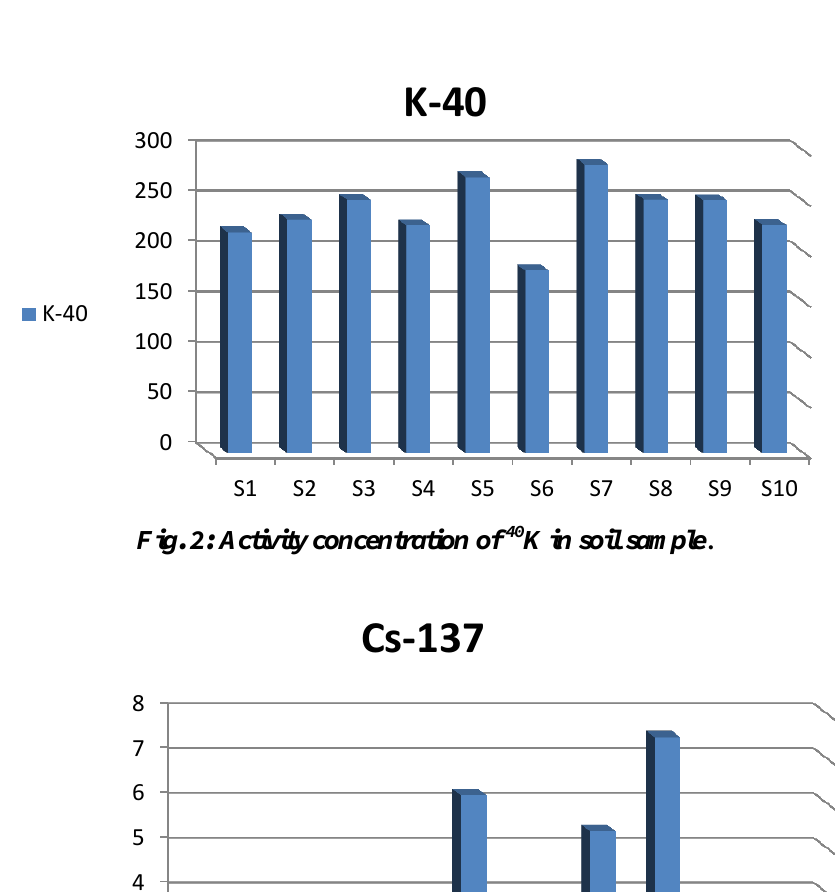
Fig. 1: Activity concentration A of radiation for, 226 Ra and 228 Ac, soil sample.